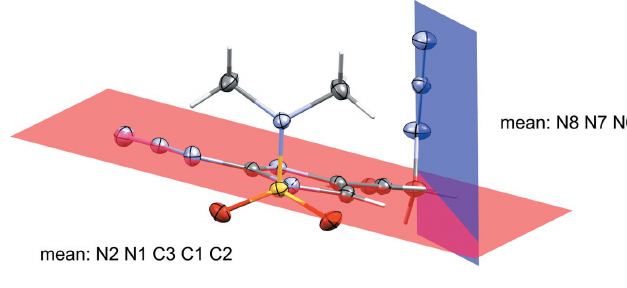
Figure 4 Dihedral planes between imidazole and allylic azide for compound 2